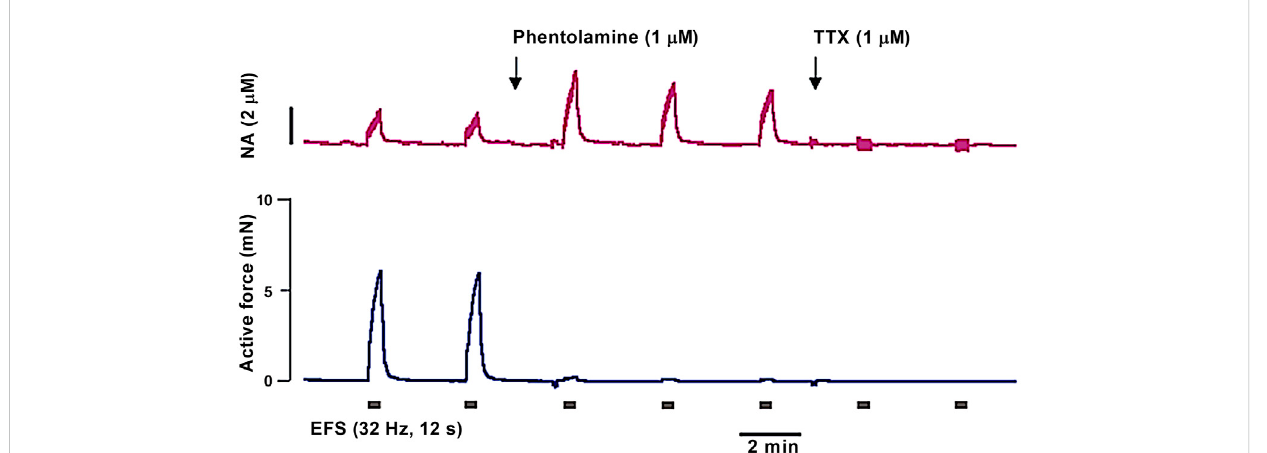
FIGURE 13 Representative recordings of the noradrenaline concentration (A) and active force (B) in response to EFS of sympathetic nerves by rectangular current pulses (85 mA, 0.1 ms) in an experiment on a segment of the rat mesenteric artery (normalized diameter 280 µm). Phentolamine greatly reduces contraction due to the blockade of postjunctional α 1 -adrenoceptors but increases the concentration of noradrenaline (NA) due to the blockade of prejunctional α 2 -adrenoceptors. In the presence of tetrodotoxin (TTX) contraction and oxidation current completely